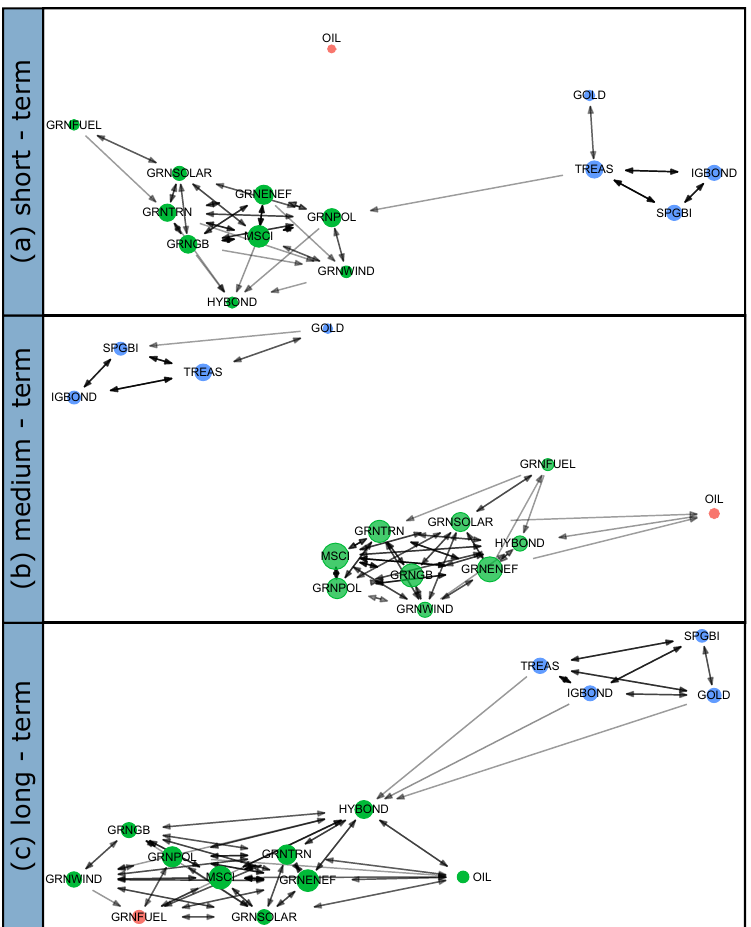
Figure 3. Wavelet coherence-based networks during the oil price collapse sub-period (from 20 June 2014 to 28 February 2016) for the three frequency bands considered. ( a ) short-term, between 2 and 5 days; ( b ) medium-term, between 5 and 22 days; ( c ) long-term, more than 22 days. Source: own elaboration using the R statistical software [65] together with packages wavScalo- gram [66], igraph [67], and ggraph